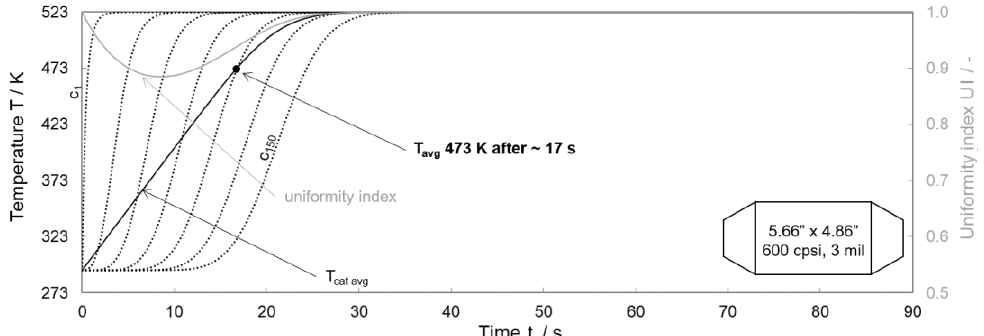
Figure A3. Heat-up of 600 cpsi, 3 mil with reduced length at steady state